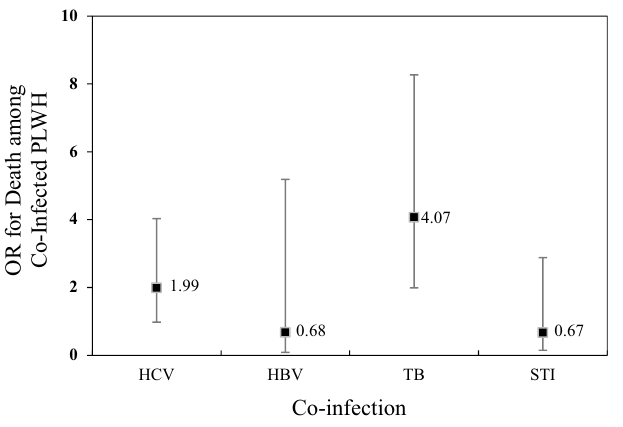
Figure 3. Association between HIV co-infections and death among the study participants; OR, 95%